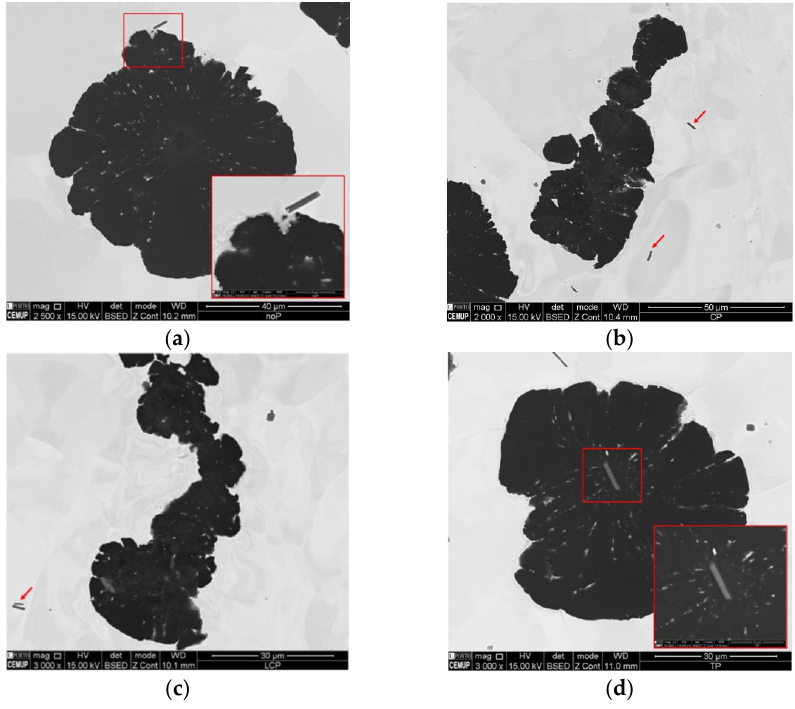
Figure 6. SEM images of ( a ) noP Un , ( b ) CP Un , ( c ) LCP Un, and ( d ) TP Un samples showing examples of microparticles observed.